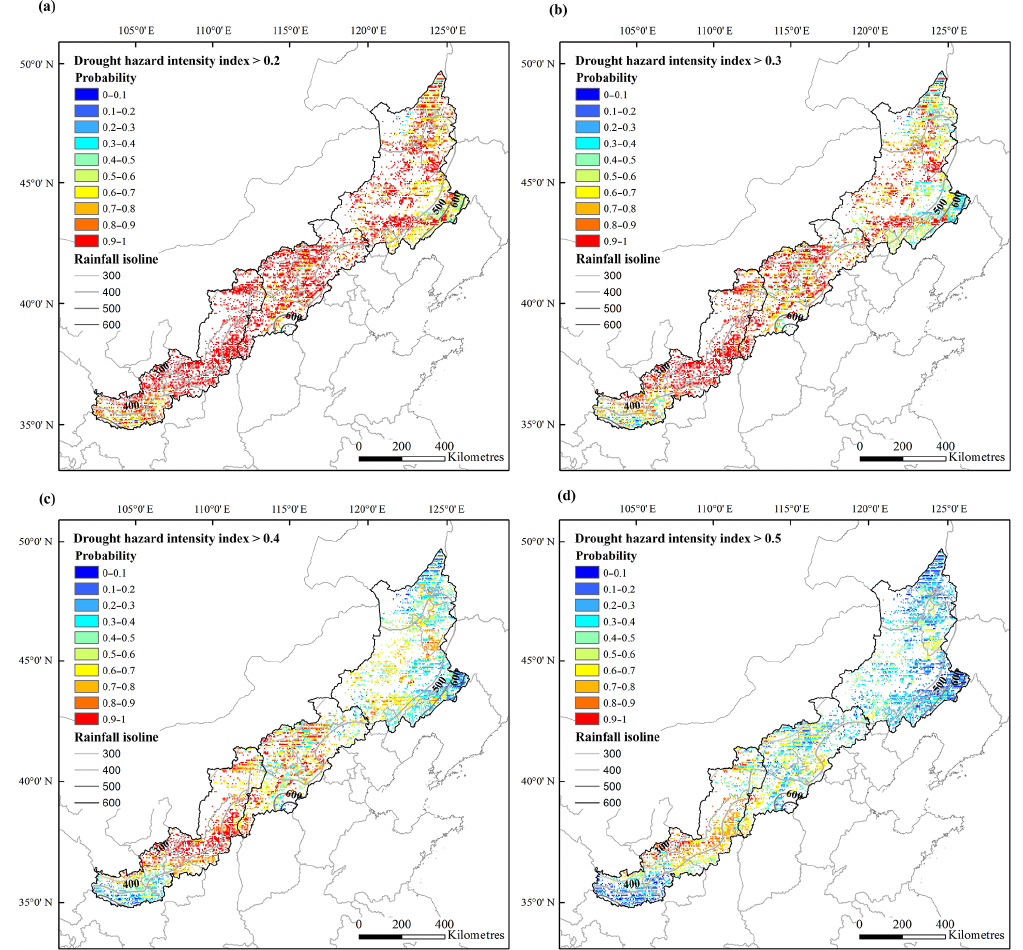
Figure 8. Probability distribution of spring maize drought hazard intensity index for different hazard levels. (a) Drought hazard intensity index ≥ 0.2 (b) drought hazard intensity index ≥ 0.3, (c) drought hazard intensity index ≥ 0.4, (d) drought hazard intensity index ≥